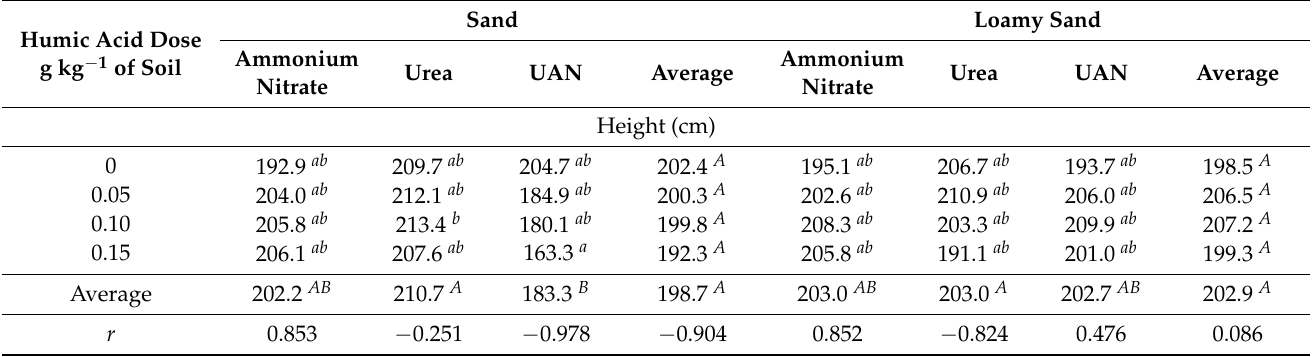
Figure 3. Effect of humic acid and fertiliser form on SPAD index in maize— Zea mays L. (averages from series). Table 1. Height, fresh weight (FW), and dry matter (DM) yield of aerial parts of maize ( Zea mays